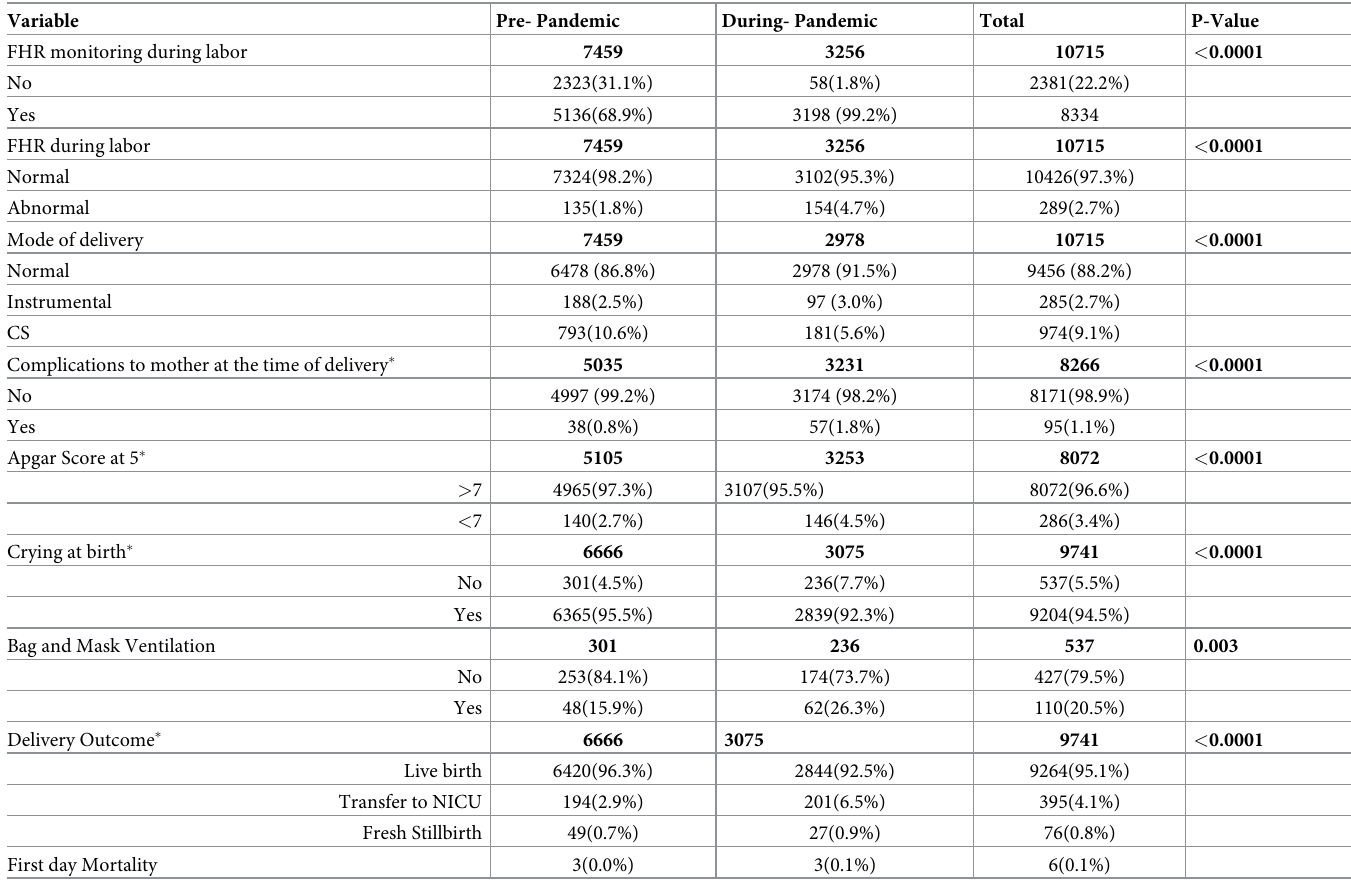
Table 5. Comparison of perinatal and neonatal outcome pre-pandemic and during the time of